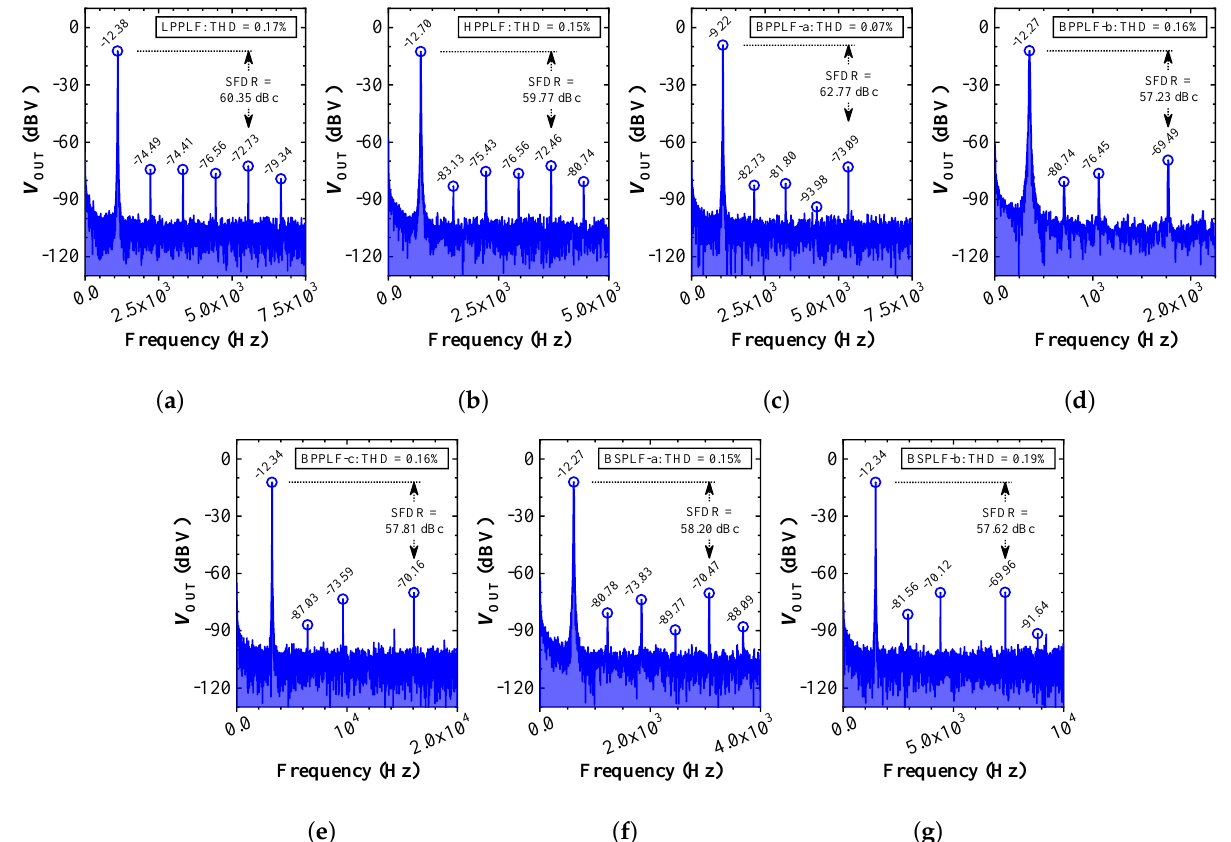
Figure 14. FFT spectrums (experimental) of the proposed filters ( α = 0.5) pertaining to the ( a ) LPPLF, ( b ) HPPLF, ( c ) BPPLF-a, ( d ) BPPLF-b, ( e ) BPPLF-c, ( f ) BSPLF-a, and ( g )